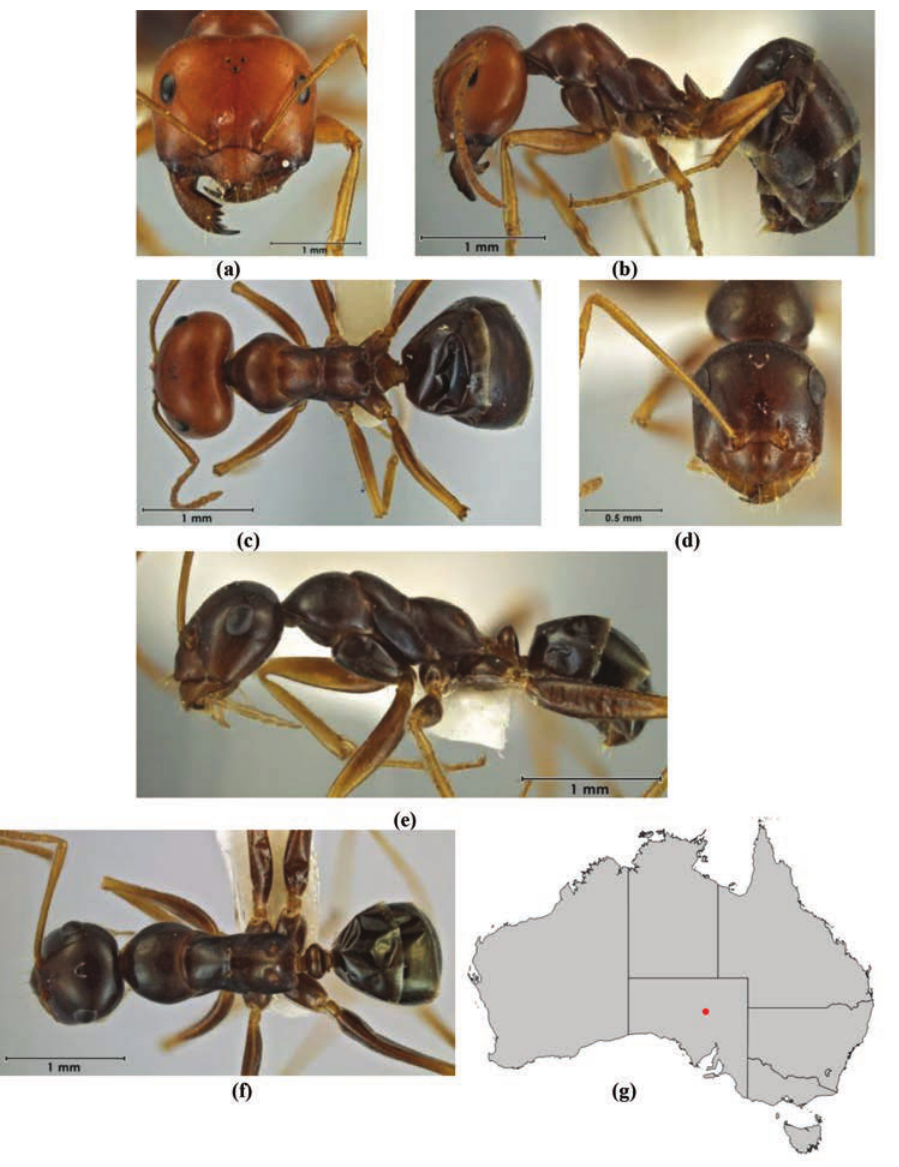
Figure 12. Melophorus fulgidus sp. n.: major worker (ANIC32-066609–top ant) paratype frons ( a ), profile ( b ) and dorsum ( c ); minor worker holotype (ANIC32-066609–bottom ant) frons ( d ), profile ( e ) and dorsum ( f ); distribution map for the species ( g